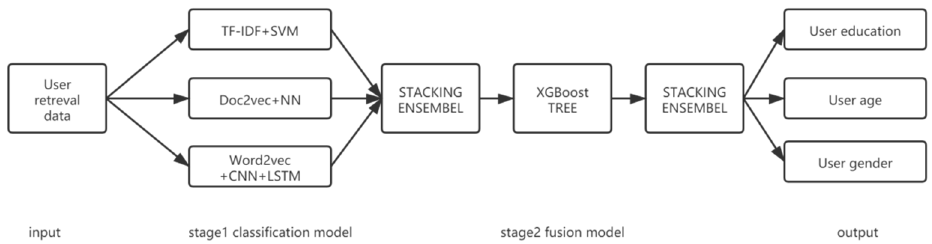
Figure 1. Structure of the Figu re 1. Structure of the multi-model.